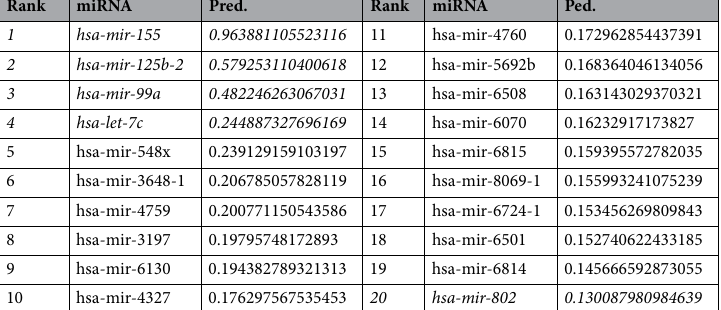
Table 7. MPM ’s prediction results for Down Syndrome and the miRNAs that are located on chromosome 21. Italics is used to highlight the associated miRNAs. The model training data does not contain the association data for Down Syndrome